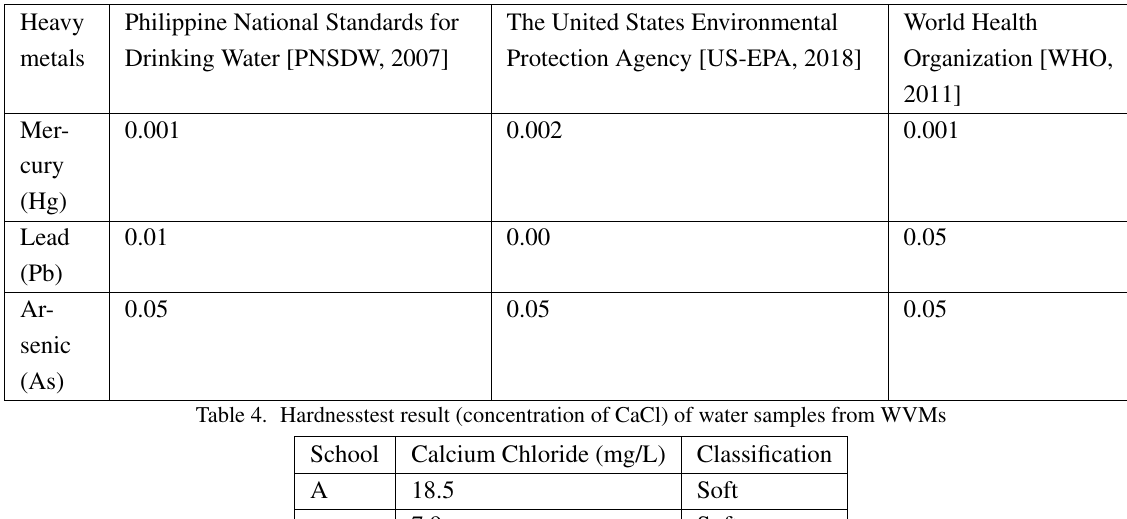
Table 3. Permissible Limits of drinking water quality forinorganic chemical constituents (mg/L) recommended by various